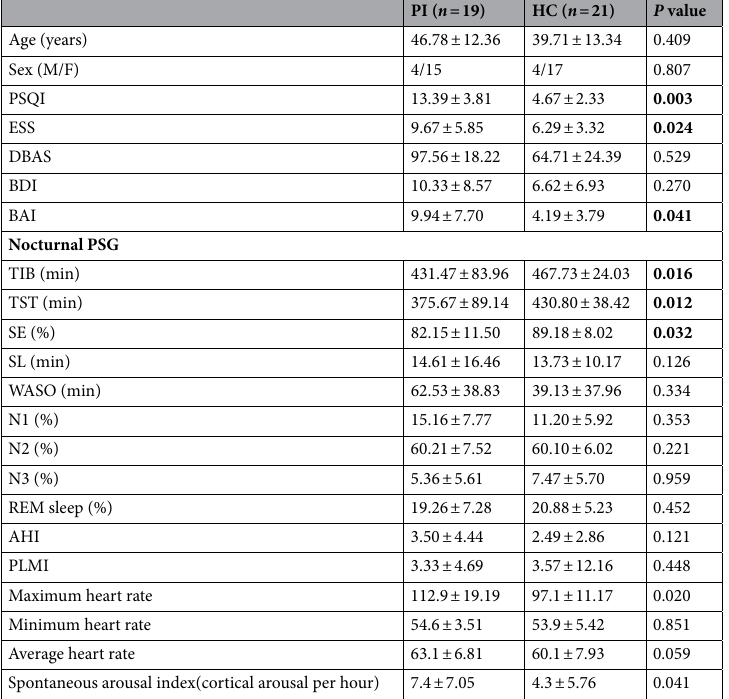
Table 1. Demographic, clinical, and polysomnographic variables of all study participants. Clinical data: nPSG data, PI group n = 18; nPSG data, HC group n = 20. BDI Beck Depression Inventory, DBAS Dysfunctional Beliefs and Attitudes about Sleep Scale, ISI Insomnia Severity Index, N1 stage 1, N2 stage 2, N3 stage 3, PSG polysomnography, PSQI Pittsburgh Sleep Quality Index, REM rapid eye movement, SE sleep